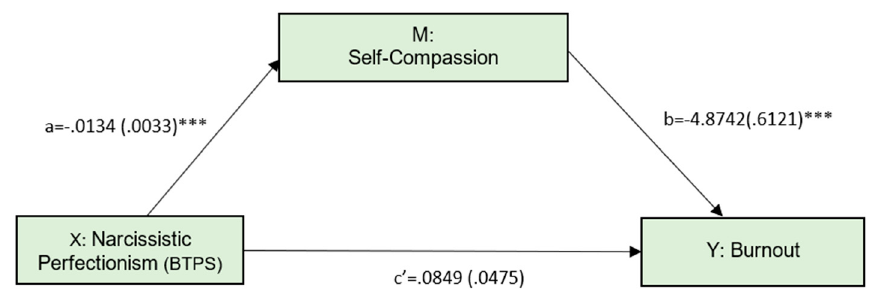
Figure 3. Simple mediation model, with narcissistic perfectionism as the predictor. Numbers represent unstandardized coefficients. Numbers in parentheses represent standard errors. *** p <